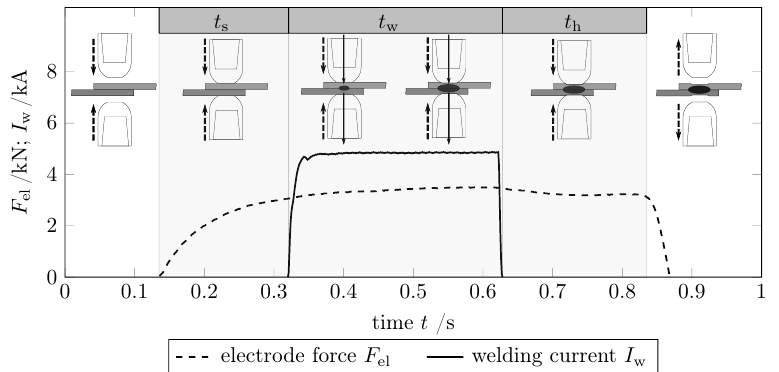
Figure 1. Course of applied electrode force F el and welding current I w over time t of a common resistance-spot-welding (RSW) process with three main stages: squeeze time t s , weld time t w , and hold time t h (schematic).